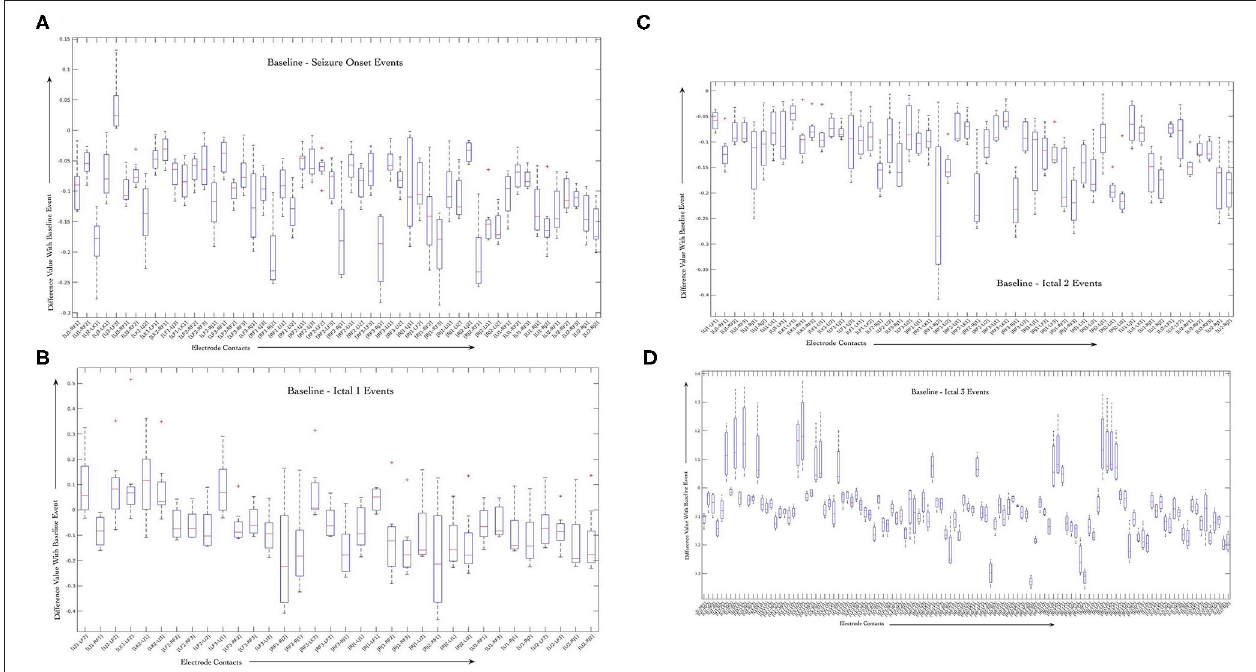
FIGURE 5 | Average variability in correlation values between the baseline stage and seizure onset (A) , ictal 1 (B) , ictal 2 (C) , and ictal 3 (D) stages across all the 8 seizures. Only correlation values computed for contacts that are on distinct electrodes were used to highlight the dynamics of interactions between different brain regions during seizure events.